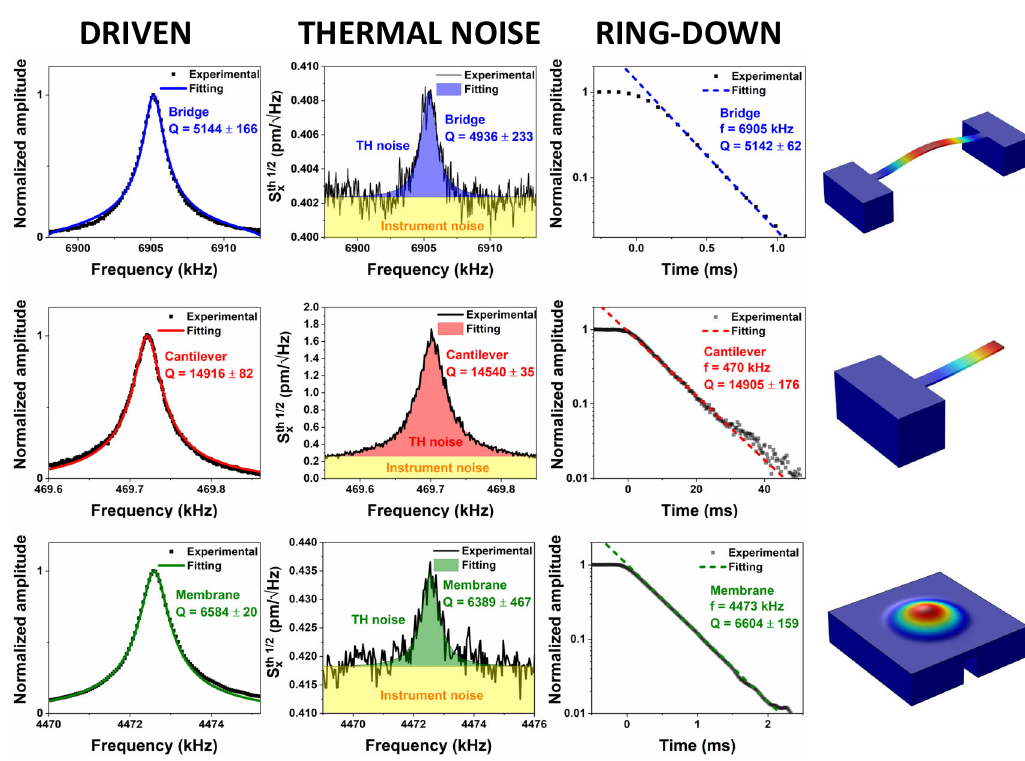
Fig. 4 Quality factor analysis with different experimental approaches. Experimental quality factor of bridge (upper panel), cantilever (central panel), and membrane (lower panel) devices extracted with three different approaches: driven the resonator to resonance, thermomechanical motion, and